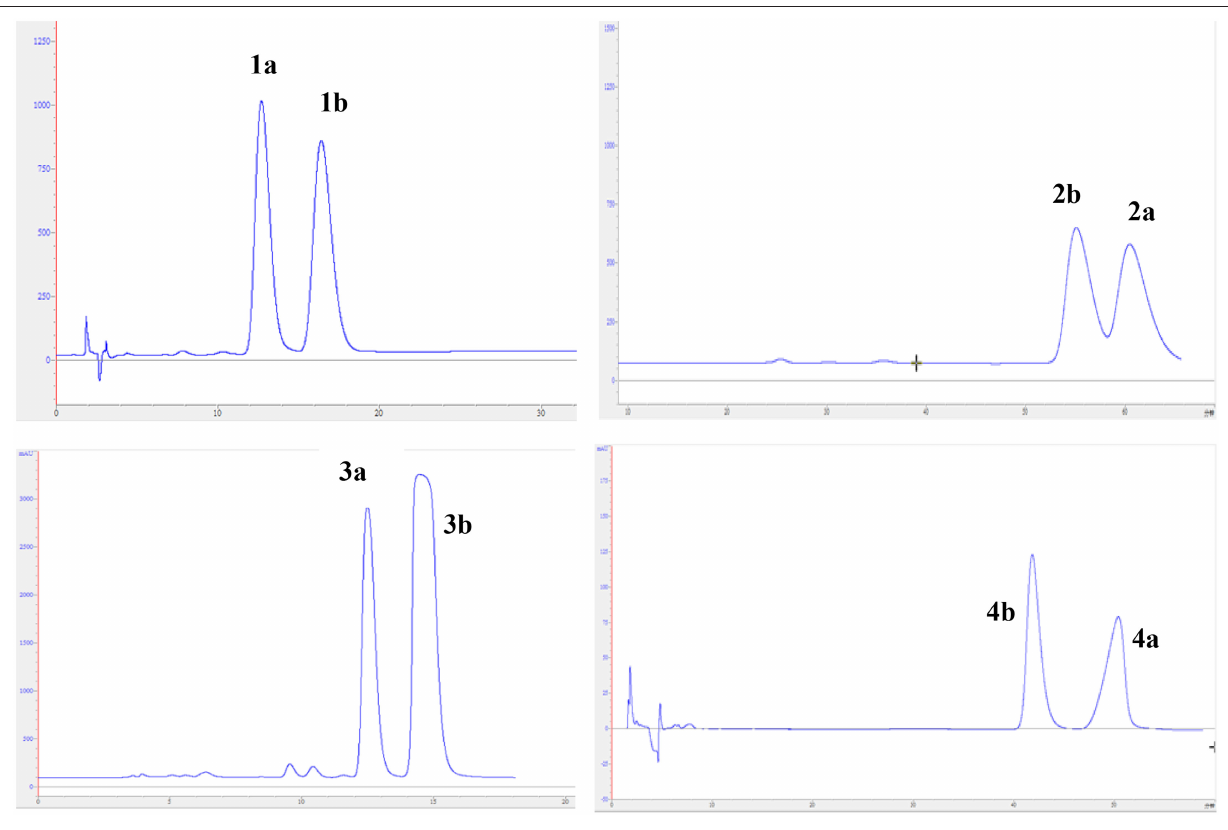
FIGURE 3 | Chiral HPLC separation profiles of compounds 1a / 1b – 4a / 4b